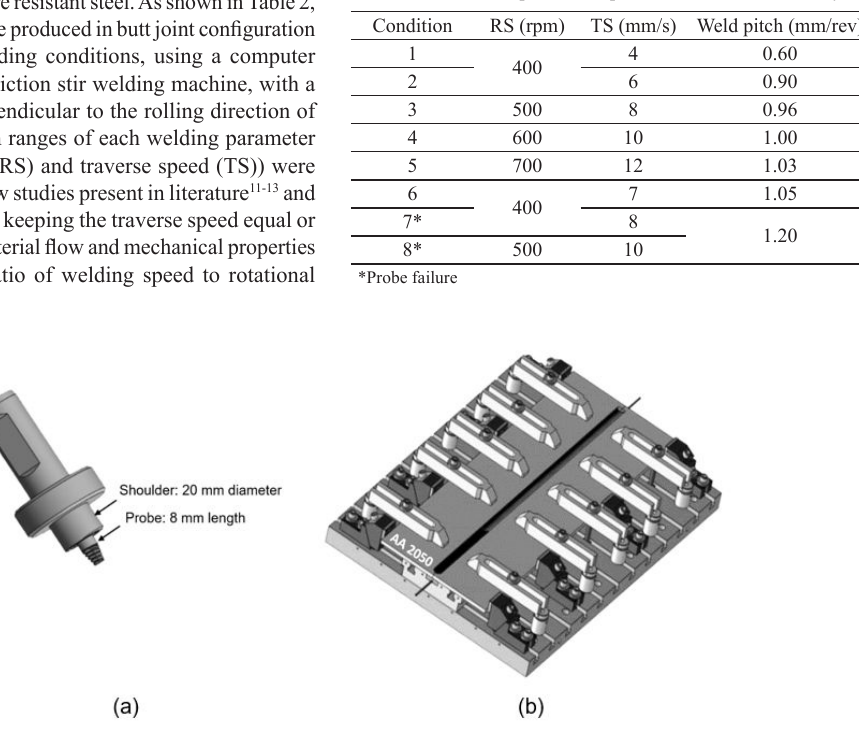
Figure 1. Schematic illustration of (a) the AA 2050-T84 butt joint configuration and the fixture table. (b) The threaded conical FSW